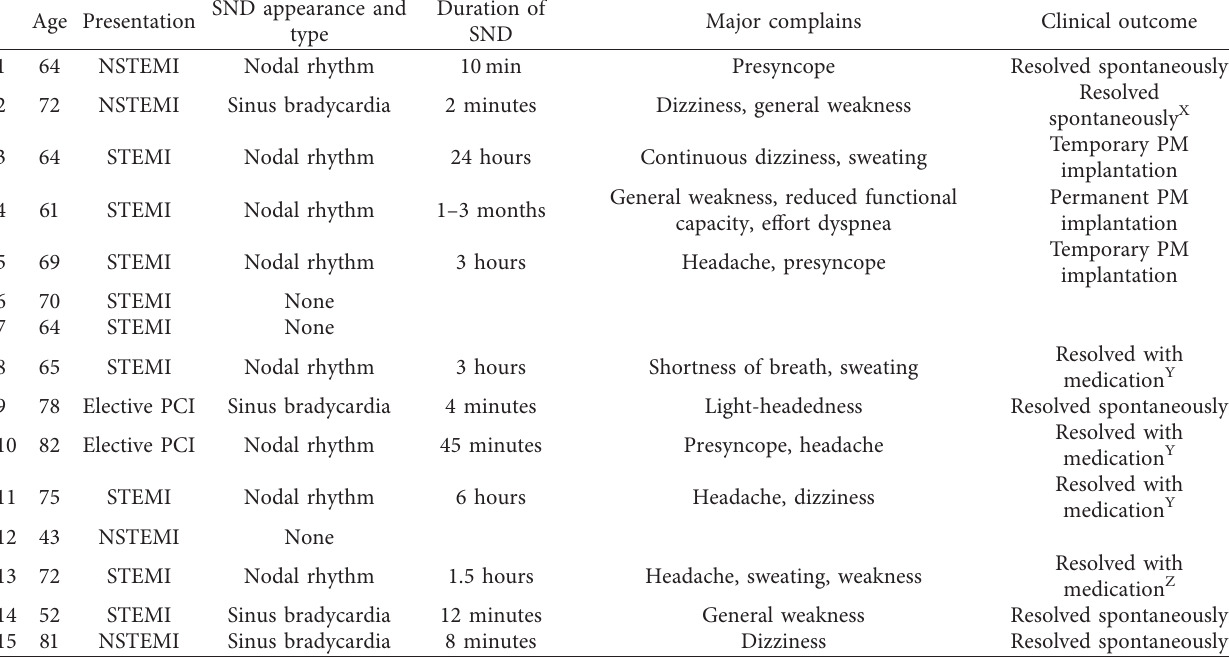
Table 3: Detailed information regarding sinus node dysfunction.